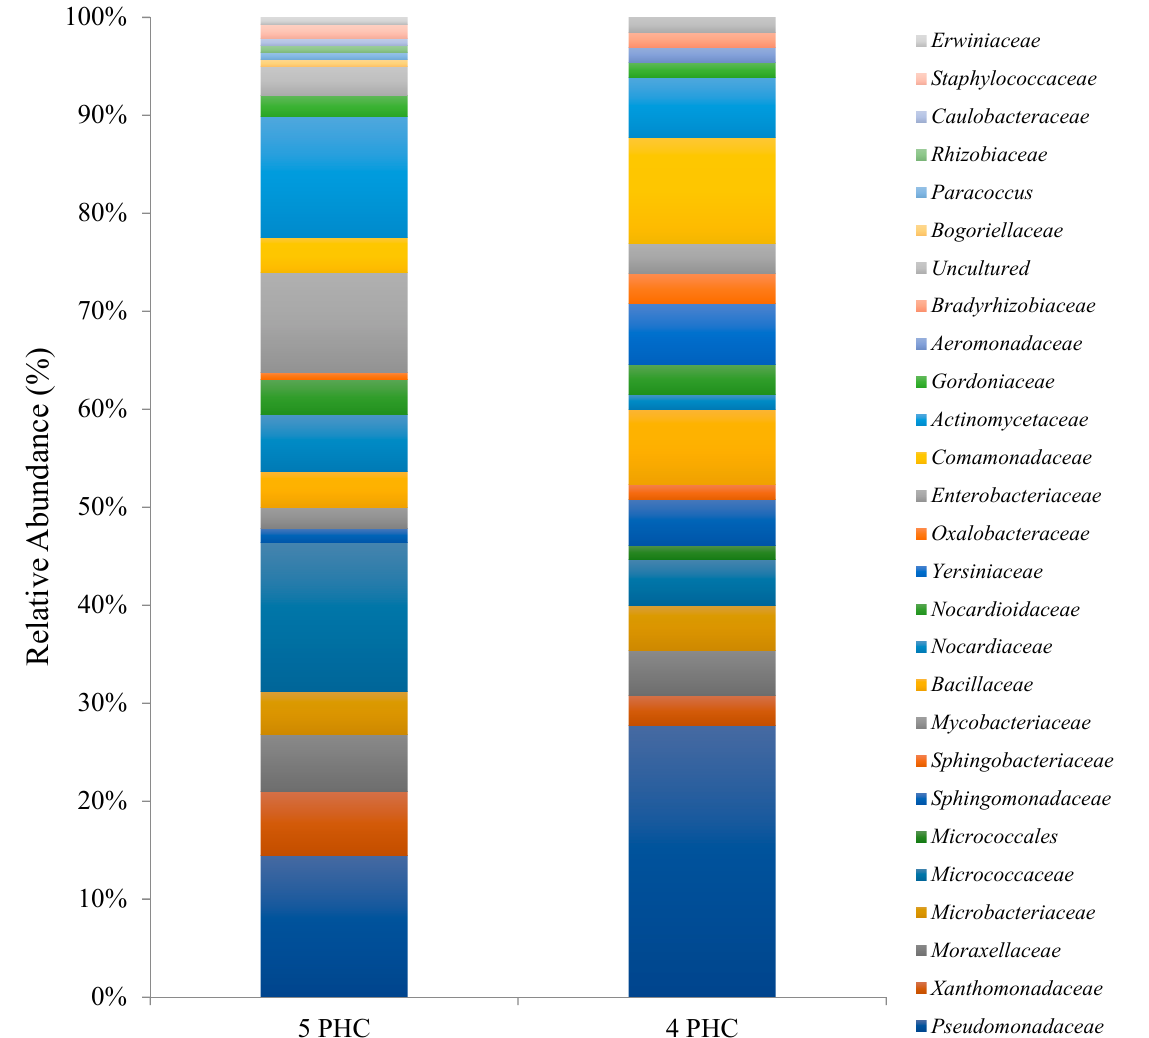
Figure 5. Bars indicate the relative abundance of genera among isolates, which are able to degrade five and four different petroleum hydrocarbons compounds (PHC) in vitro.